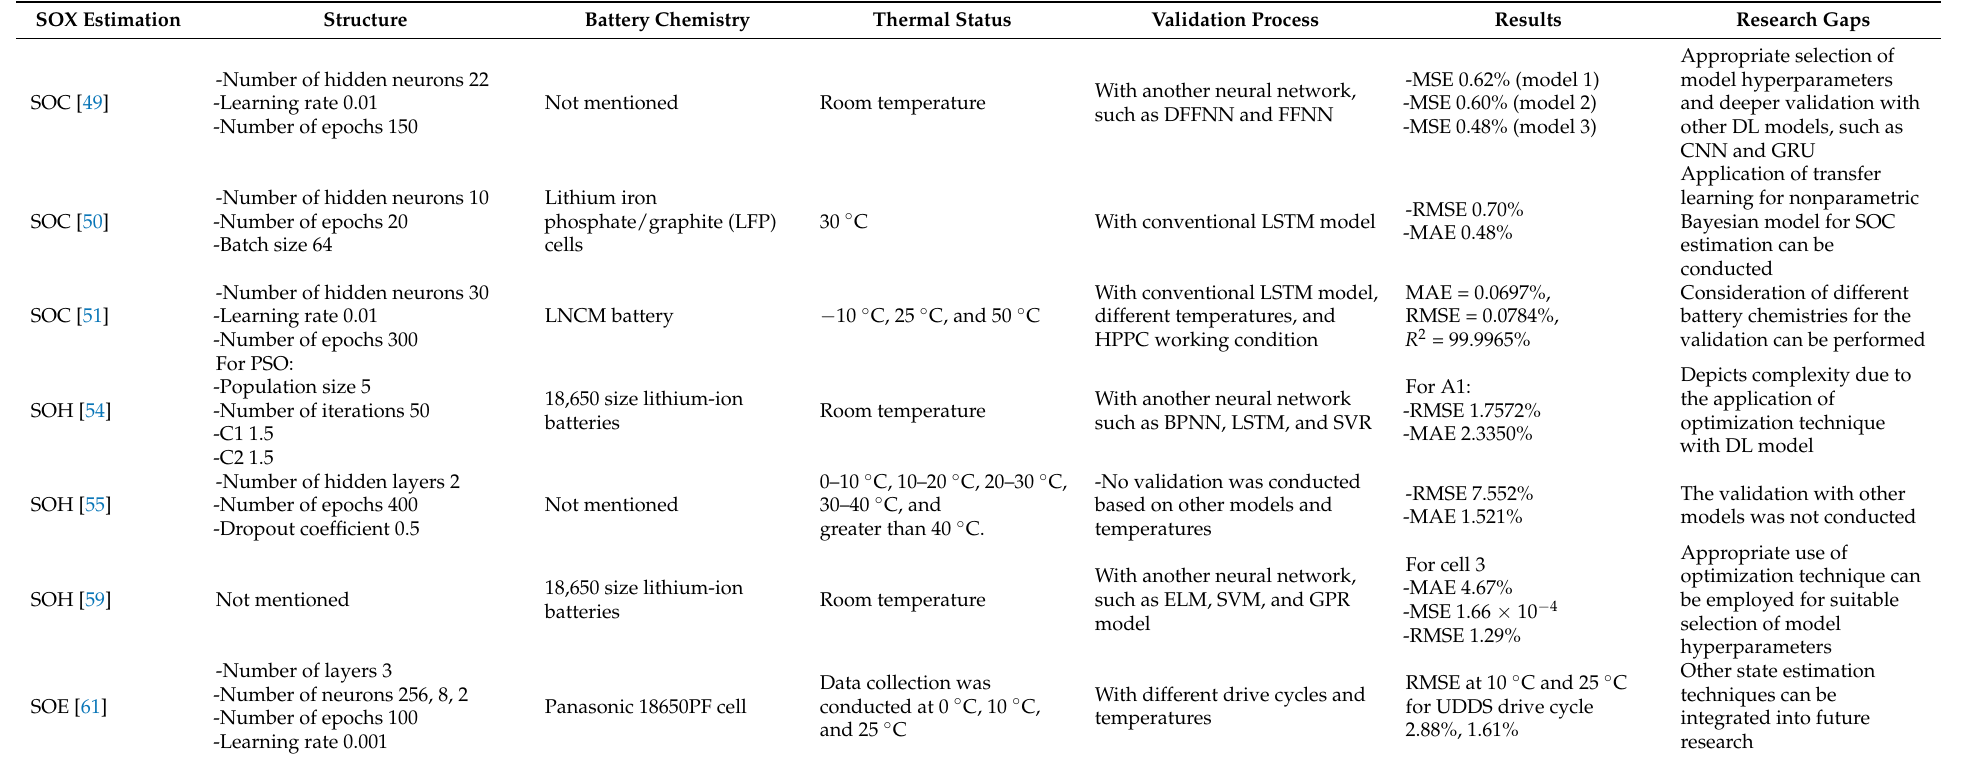
Table 3. Summary of LSTM-based SOX estimation